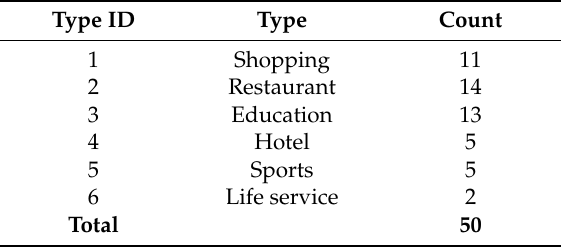
Table 3. Public places of interest